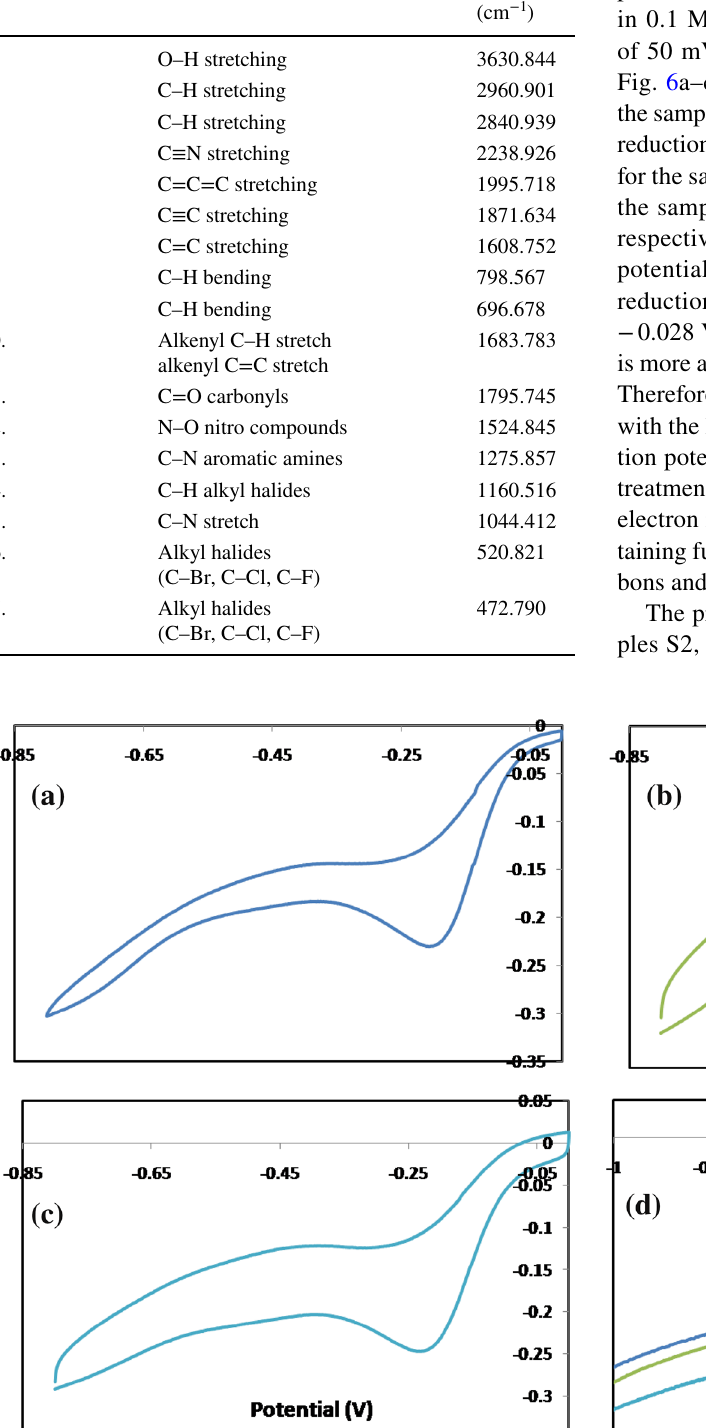
2 saturated 0.1 M KOH solution at a scan